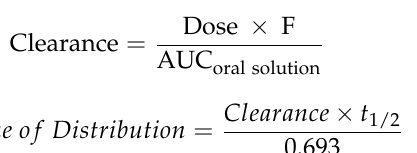
Figure A3. Scanning electron microscopy images of manufactured acalabrutinib ASDs.